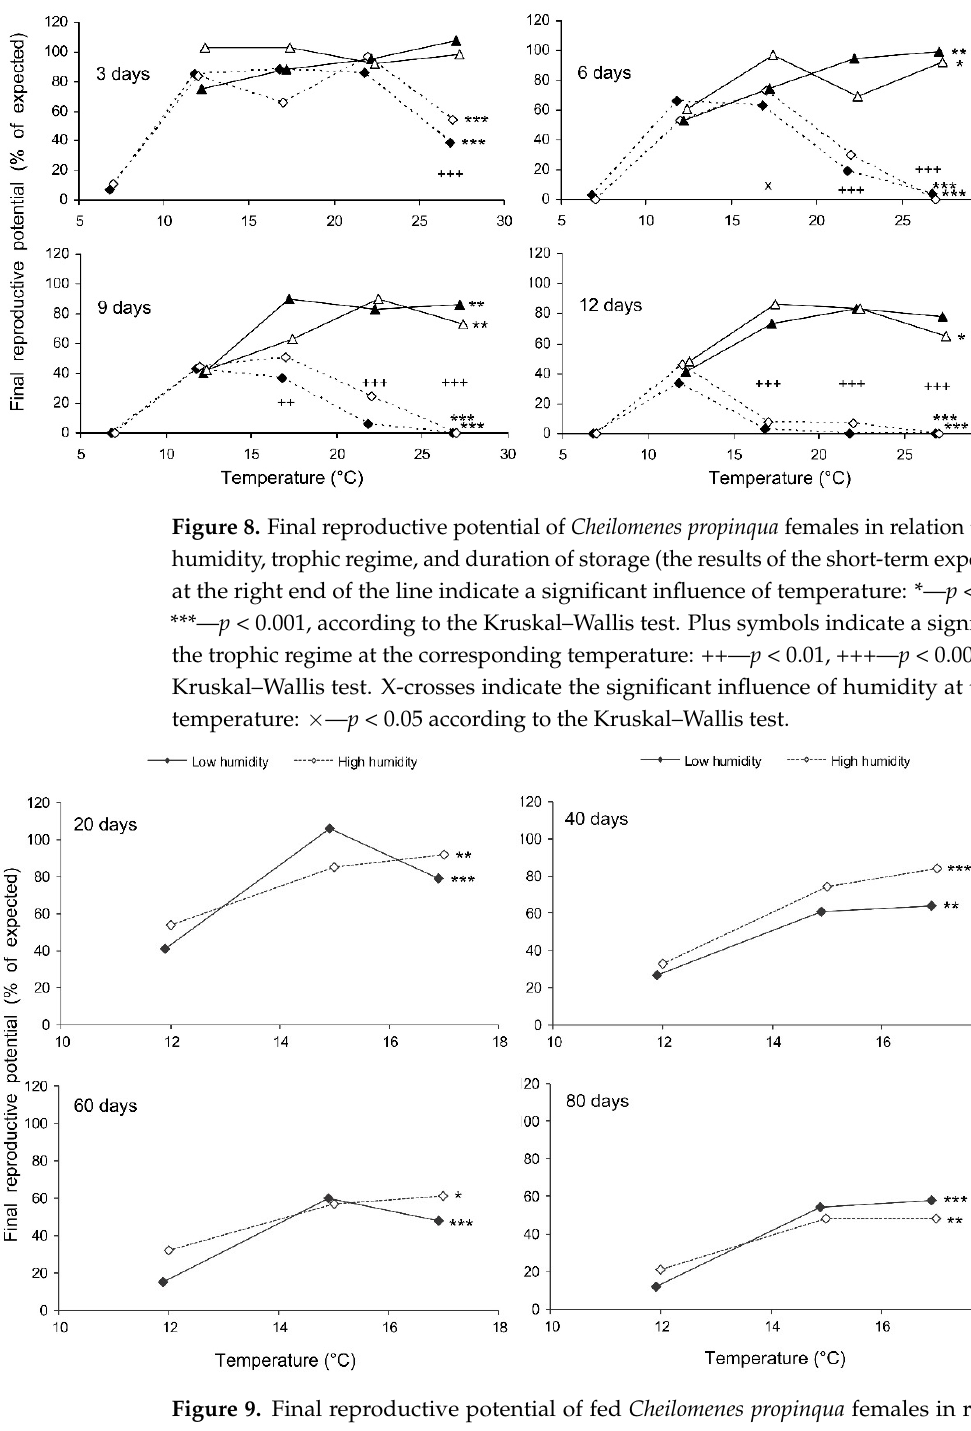
Figure 9. Final reproductive potential of fed Cheilomenes propinqua females in relation to the temperature, humidity, and duration of storage (the results of the long-term experiment). Asterisks at the right end of the line indicate the significant influence of temperature: *— p < 0.05, **— p < 0.01, ***— p < 0.001, according to the Kruskal–Wallis test.